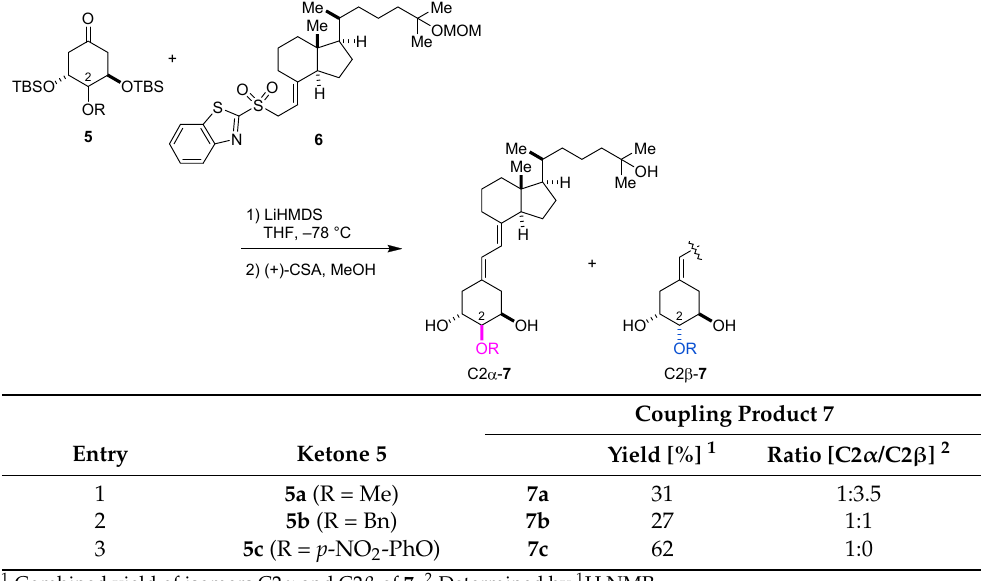
Table 1. Diastereomeric ratio of coupling product 7 in Julia-type coupling of ketone 5 with sulfone 6